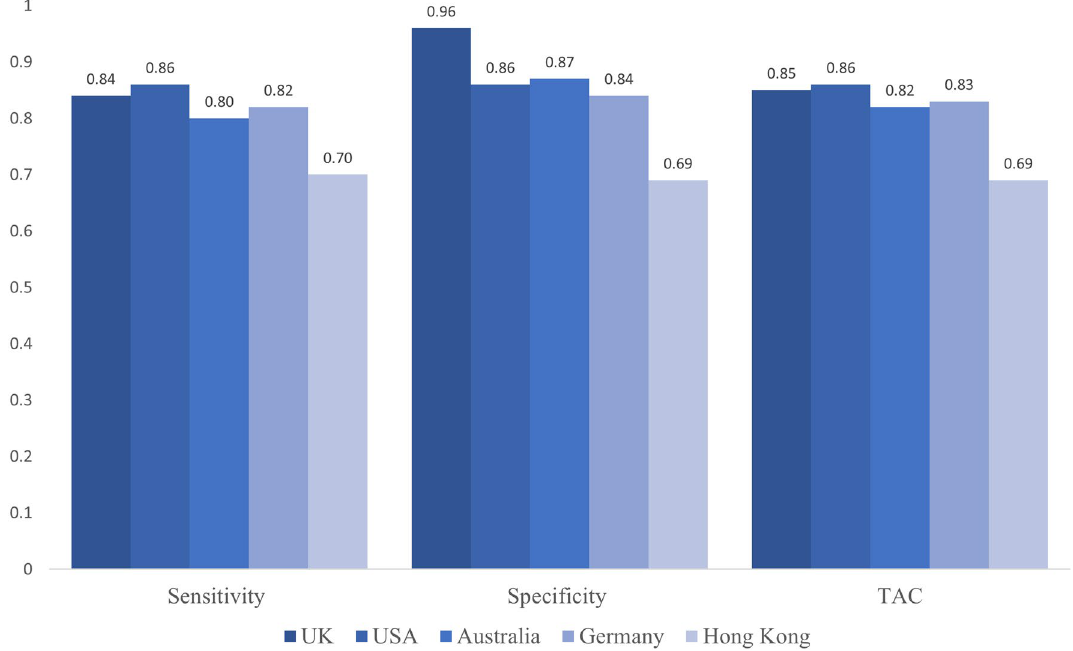
Figure 1. Accuracy of the leave-one-person-out cross validation of the all-variables-machine-learning model by